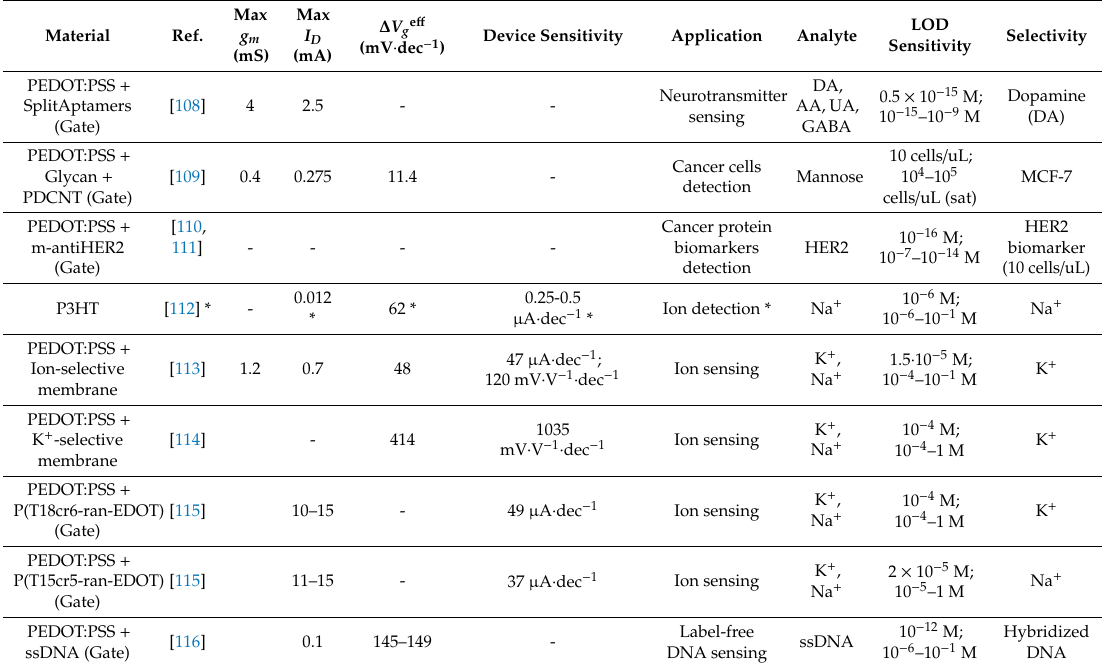
Table 1. Summary of analytical performances of di ff erent OECT-based